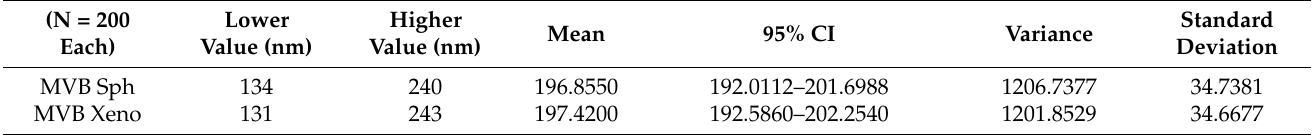
Figure 12. ANOVA test with Bonferroni correction of diameter values of apical-secreted and basolateral-secreted exosomes in MTSs and xenografts. Sph Apical: exosome diameter in spheroid apical secretion; Sph Lateral: exosome diameter in spheroid basolateral secretion; Xeno Apical: exosome diameter in xenograft apical secretion; Xeno Lateral: exosome diameter in xenograft basolat- eral secretion. Table 3. Summary statistic of MVB diameter values in MTSs and xenograft. Table 3. Summary statistic of MVB diameter values in MTSs and xenograft.